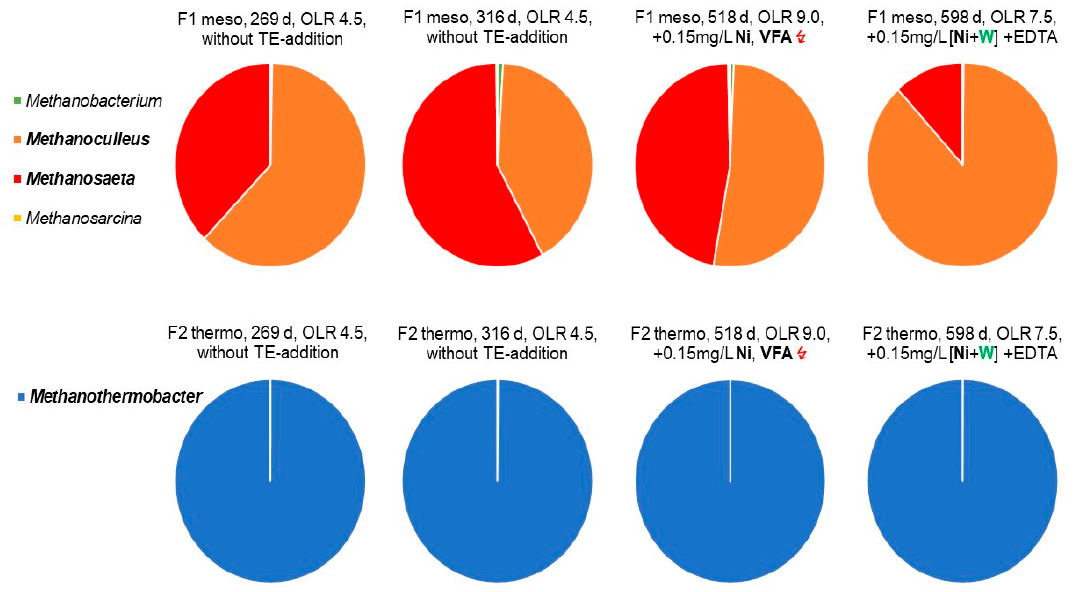
Figure 5. Taxonomic profiling of archaeal communities residing during long-term straw fermentation in continuously stirred laboratory fermenters, based on high-throughput 16S rRNA gene amplicon sequencing at different loading rates and successive nickel/tungsten supplementation. Relative abundances of the most abundant genera of archaeal subcommunities are shown. Complementary, graphical counterpart to Figure 2, with the number of methanogenic cells in fermenter F1 (mesophilic, 41 °C) and F2 (thermophilic, 58 °C).